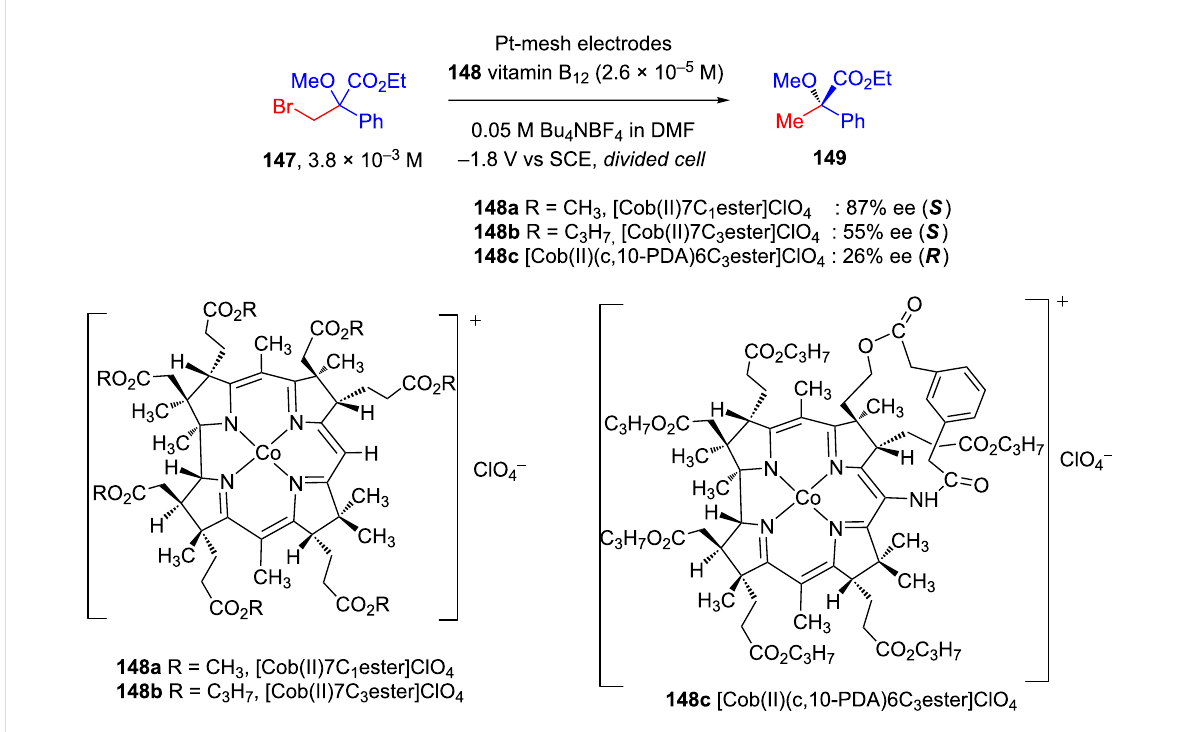
Scheme 48: Asymmetric electrochemical transformation mediated by hydrophobic vitamin B12.